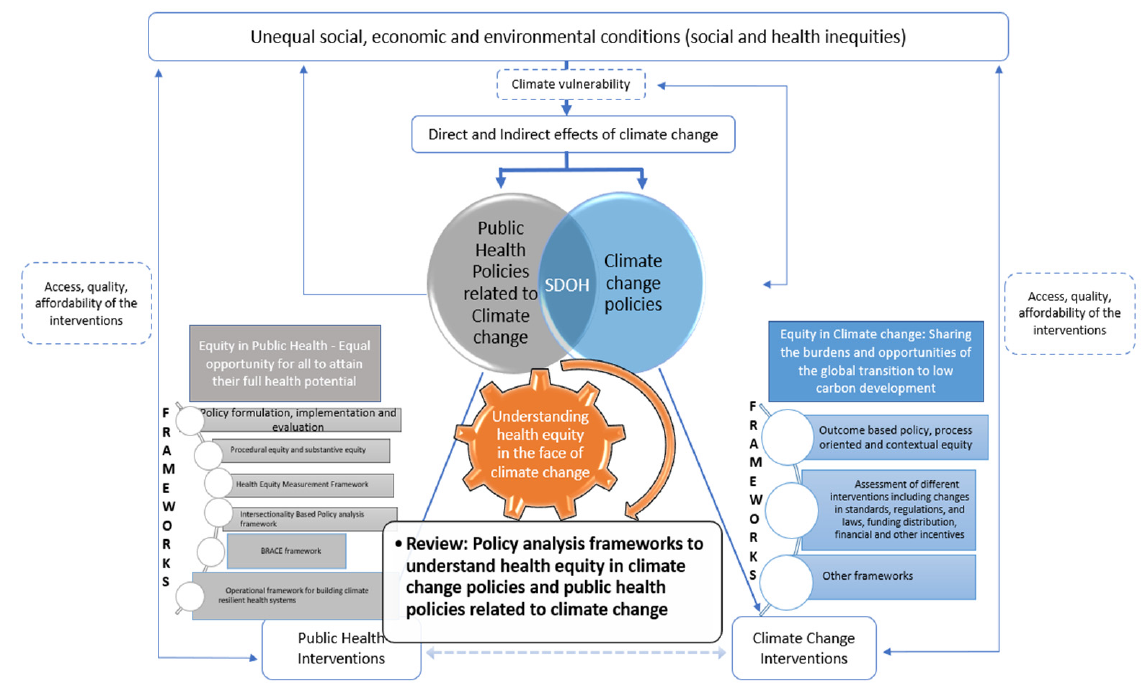
Figure 1. Conceptual framework of equity in health and equity in climate change and the review questions.